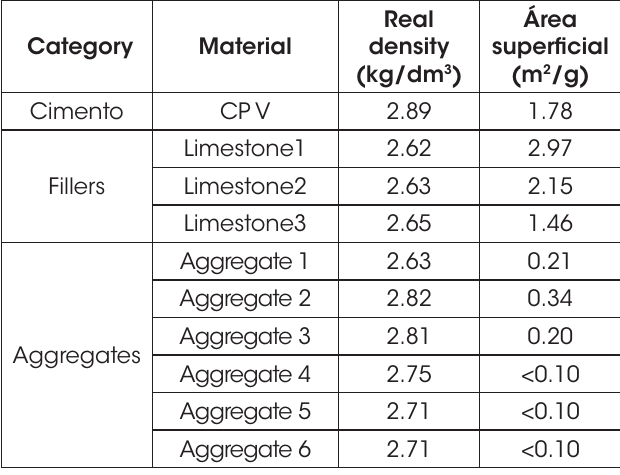
Real density and surface area (BET) of